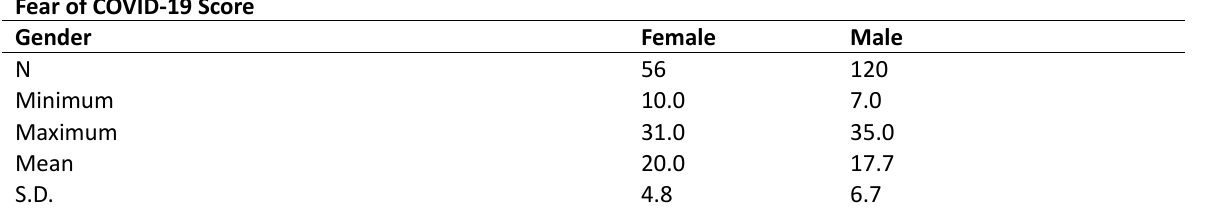
Table 8. Fear Scores of Participants Fear of COVID-19